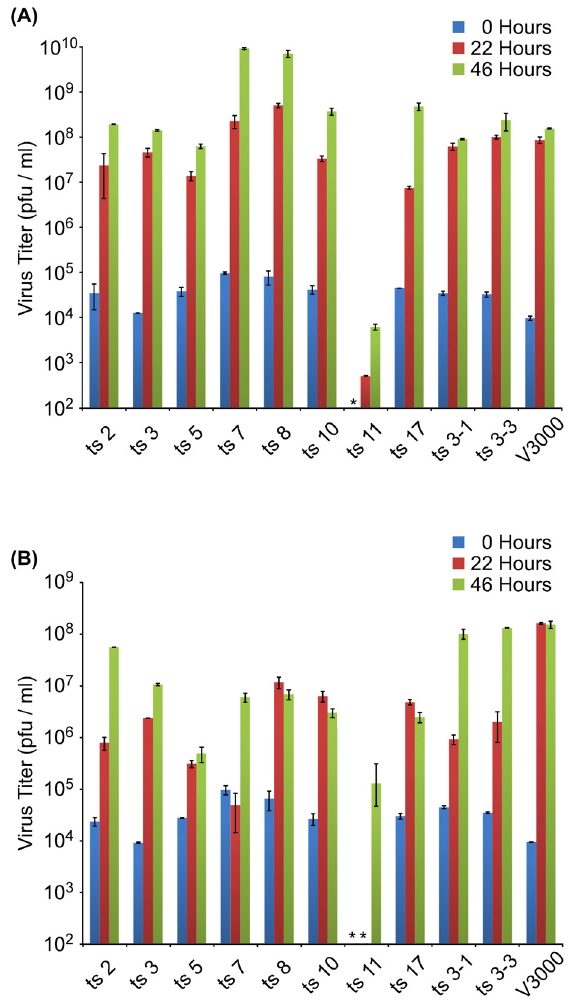
Figure 6. Virus replication at 30 u C and 40 u C. Single-cycle growth curves of viruses predicted to be ts based on functional mapping. Vero cells were infected in duplicate at an MOI of 1, and incubated at either 30 u C (A) or 40 u C (B). Aliquots were removed at 0, 22 and 46 hr after infection and virus was measured by plaque assay on Vero cells. Samples in which virus was not detected are indicated with an asterisk